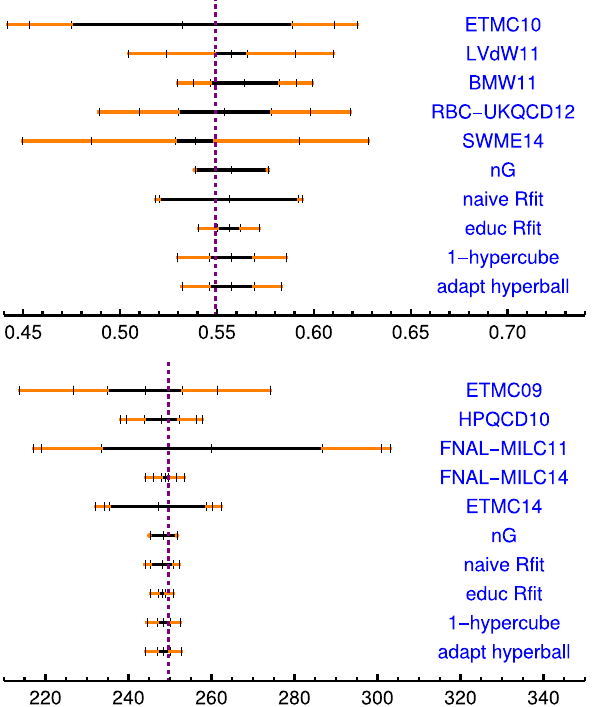
¯ MS ( 2GeV ) andtheaveragesresultingfromthe Fig. 12 Top inputsfor B K differentmodelsconsideredhere. Bottom sameforthelatticedetermina- tions of the D s -meson decay constant (in MeV). The black range gives the statistical error. For each individual input, the solid yellow range indicates the 3 σ interval according to the adaptive hyperball approach, whereas the interval corresponding to the 1-fixed hypercube approach is given by the vertical lines in the middle of the solid yellow inter- vals . For average according to the different approaches, the black range corresponds again to the 3 σ statistical error, whereas the yellow range corresponds to the 3 σ interval following the corresponding approach.